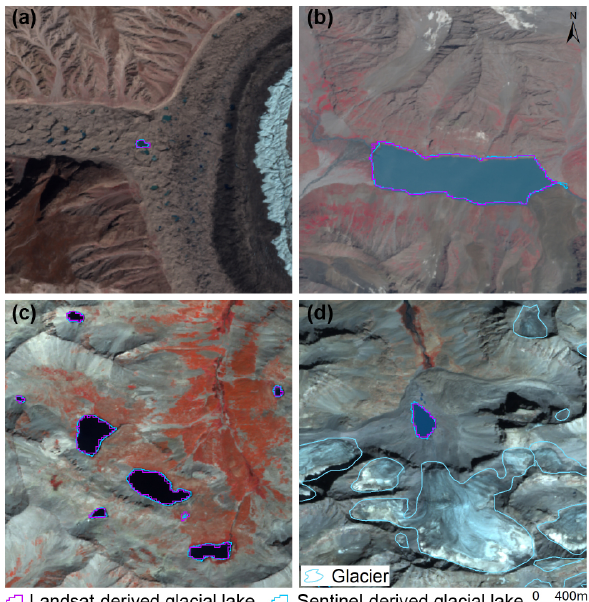
Figure 10. High consistency of lake extents extracted from Land- sat and Sentinel-2 images. Lake types shown include a supraglacial lake (a) , a glacier-fed moraine-dammed lake (b) , an unconnected glacial-erosion lake without glacier melt supply (c) and a glacier- fed moraine-dammed lake (d)